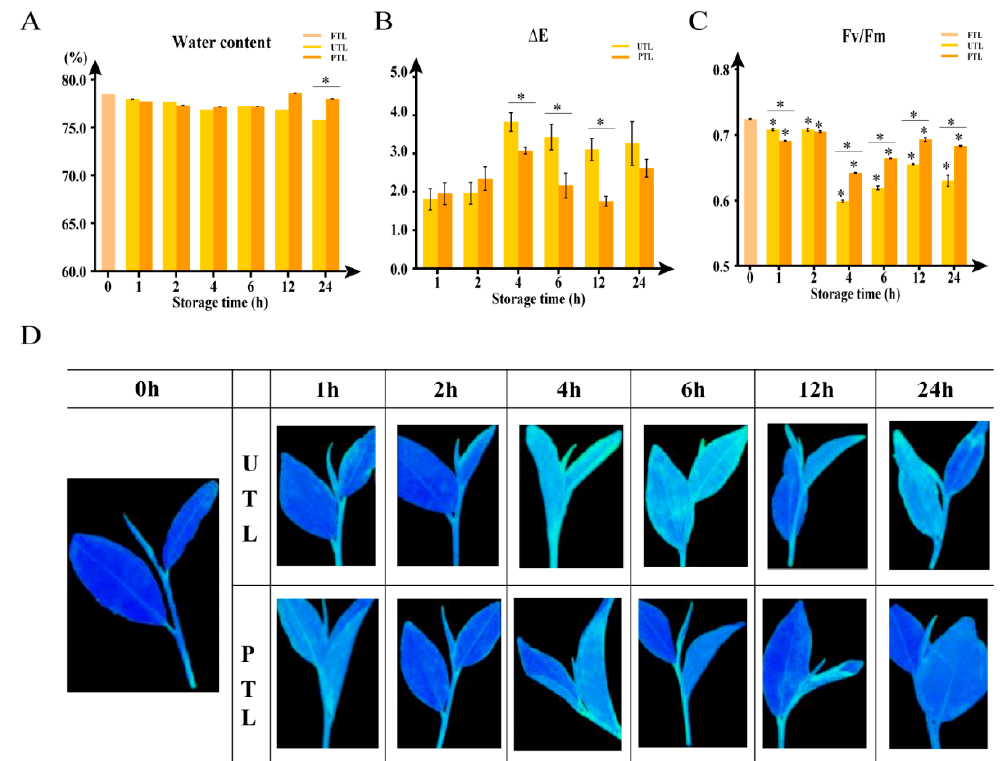
Figure 1. The effects of storage conditions on tea leaves, as indicated by changes in water content, color ( ∆ E), and leaf damage (Fv/Fm) within 24 h. ( A ) The water content of FTL, UTL, and PTL at different time points. ( B ) ∆ E of UTL and PTL within 24 h, relative to FTL. ( C ) The Fv/Fm values of FTL, UTL, and PTL over 24 h. ( D ) Images of chlorophyll fluorescence in FTL, UTL, and PTL at different time points. Dunnett’s multiple comparisons and t -test were used to identify significant differences (*, p < 0.05). Values are the mean ± SEM of all replicates.